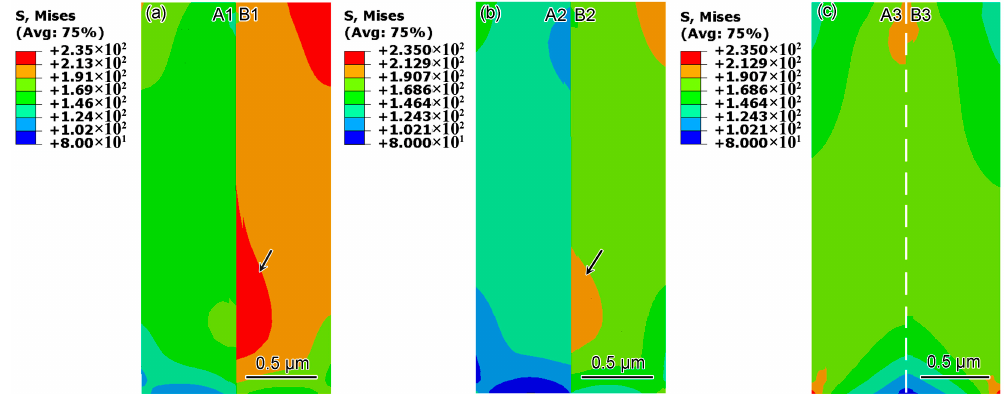
Figure 2. Contours of stress of the three specimens when the engineering strain is 0.05%. ( a ) BC1, ( b ) BC2 and ( c ) BC3.